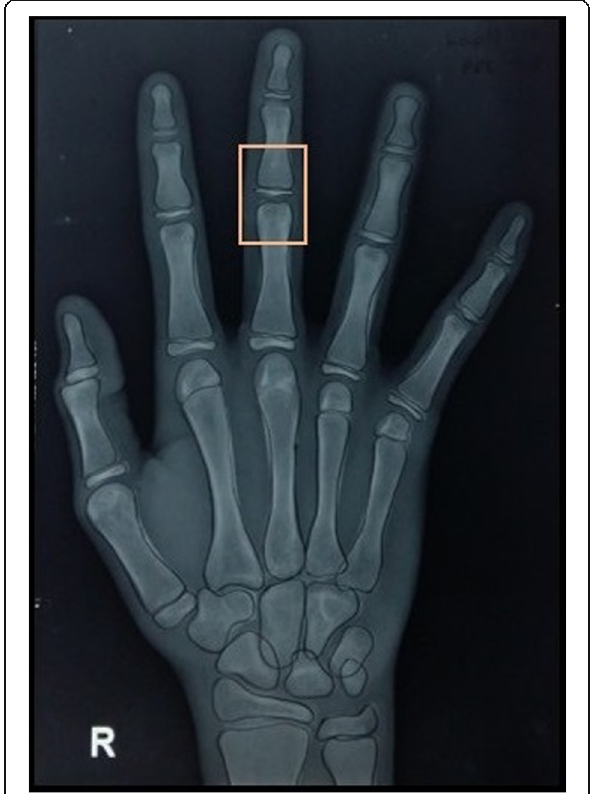
Fig. 2 Hand wrist radiograph of a subject showing modified MP3 stage of right